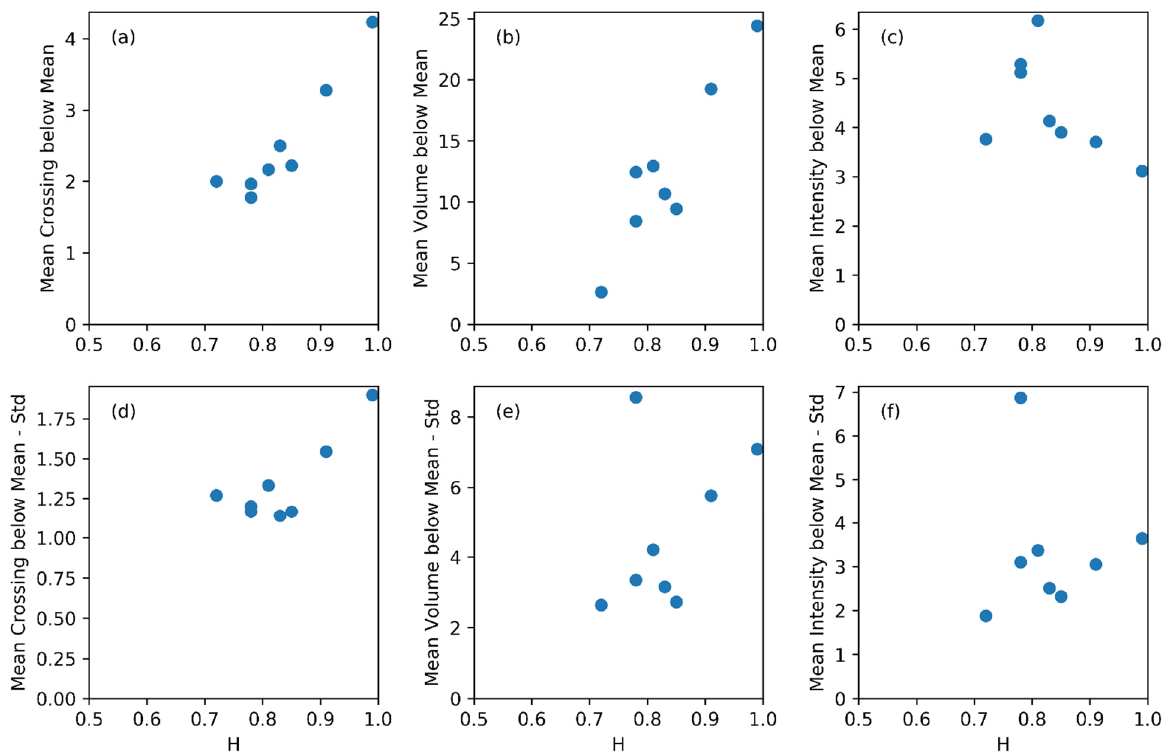
Figure 11. Plots of 𝐷(cid:3365) , 𝑆𝑉(cid:3364)(cid:3364)(cid:3364)(cid:3364) and 𝐼̅ against H for the mean crossing level ( a – c ) and the MSD level ( d – f ).